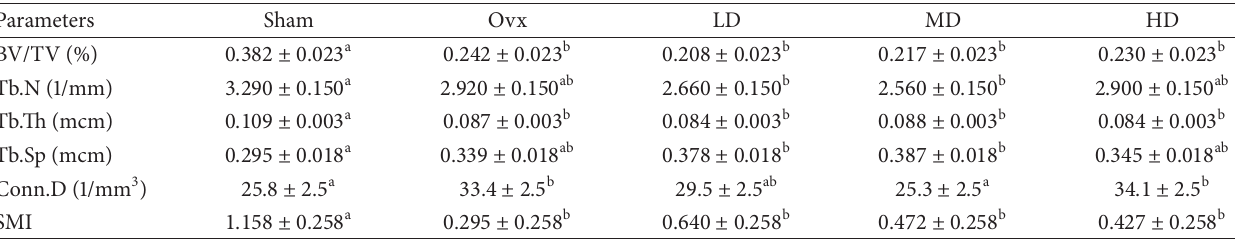
Table 4: Effects of ovariectomy (Ovx) and three doses of vitamin E: low dose (LD, 300 mg/kg diet), medium dose (MD, 525 mg/kg diet), and high dose (HD, 750 mg/kg diet) on three-dimensional (3D) microcomputed tomography ( 𝜇 CT) structural parameters of fifth lumbar